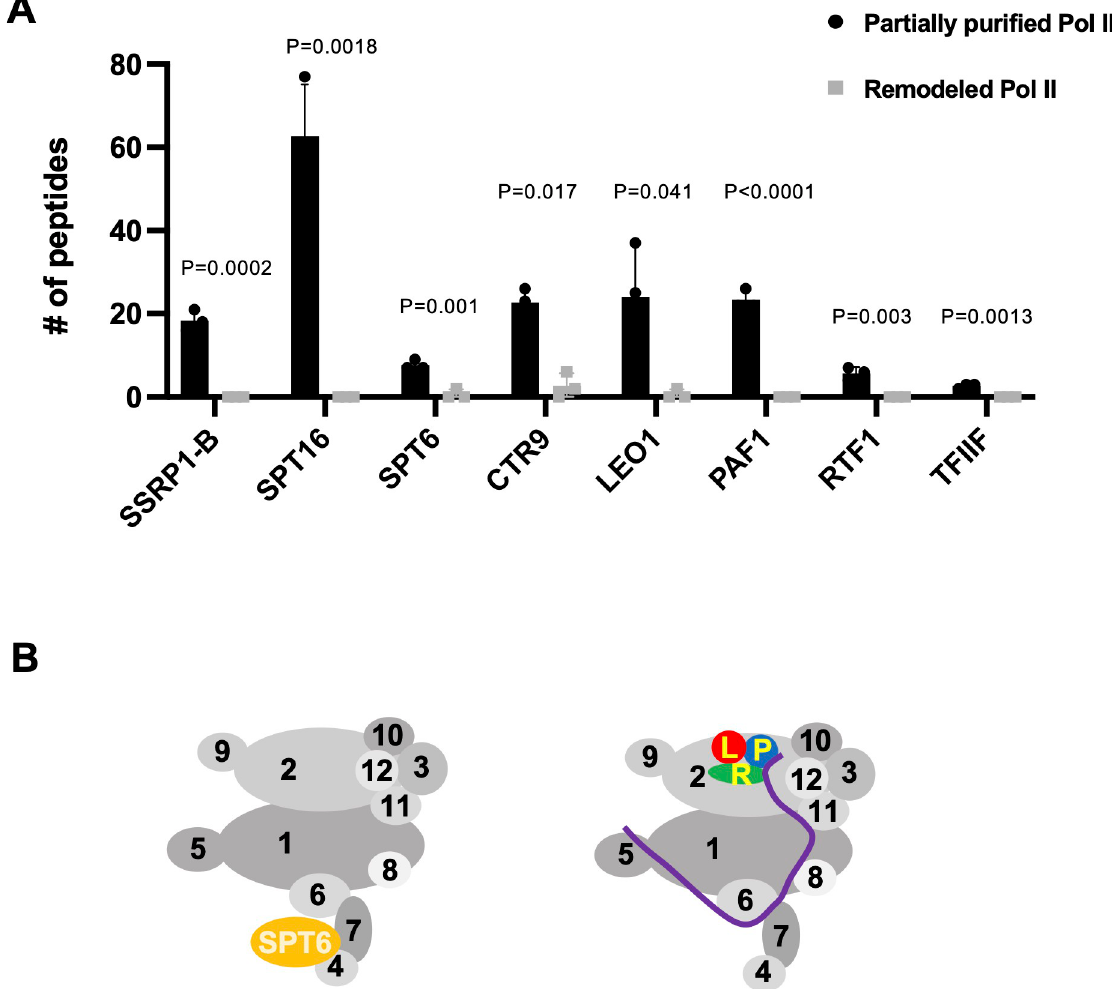
Fig 2. Analyses on transcription elongation factors. (A) Analyses of peptide counts of the FACT complex (SSRP1-B, SPT16), SPT6, PAF1-C, and TFIIF in partially purified Pol II and remodeled Pol II. Y-axis lists numbers of identified peptides corresponding to each gene. P values were calculated via a two-tailed T-test, a built-in function in Prism. The summarized nLC-MS/MS data are listed in S1 Table. The original data can be found in S1–S6 Datasets. (B) Schematic presentation of Pol II interactions with SPT6 and PAF1-C during DNA- dependent transcription, based on a reference [16]. P, PAF1. L, LEO1. R, RTF1. Purple line,